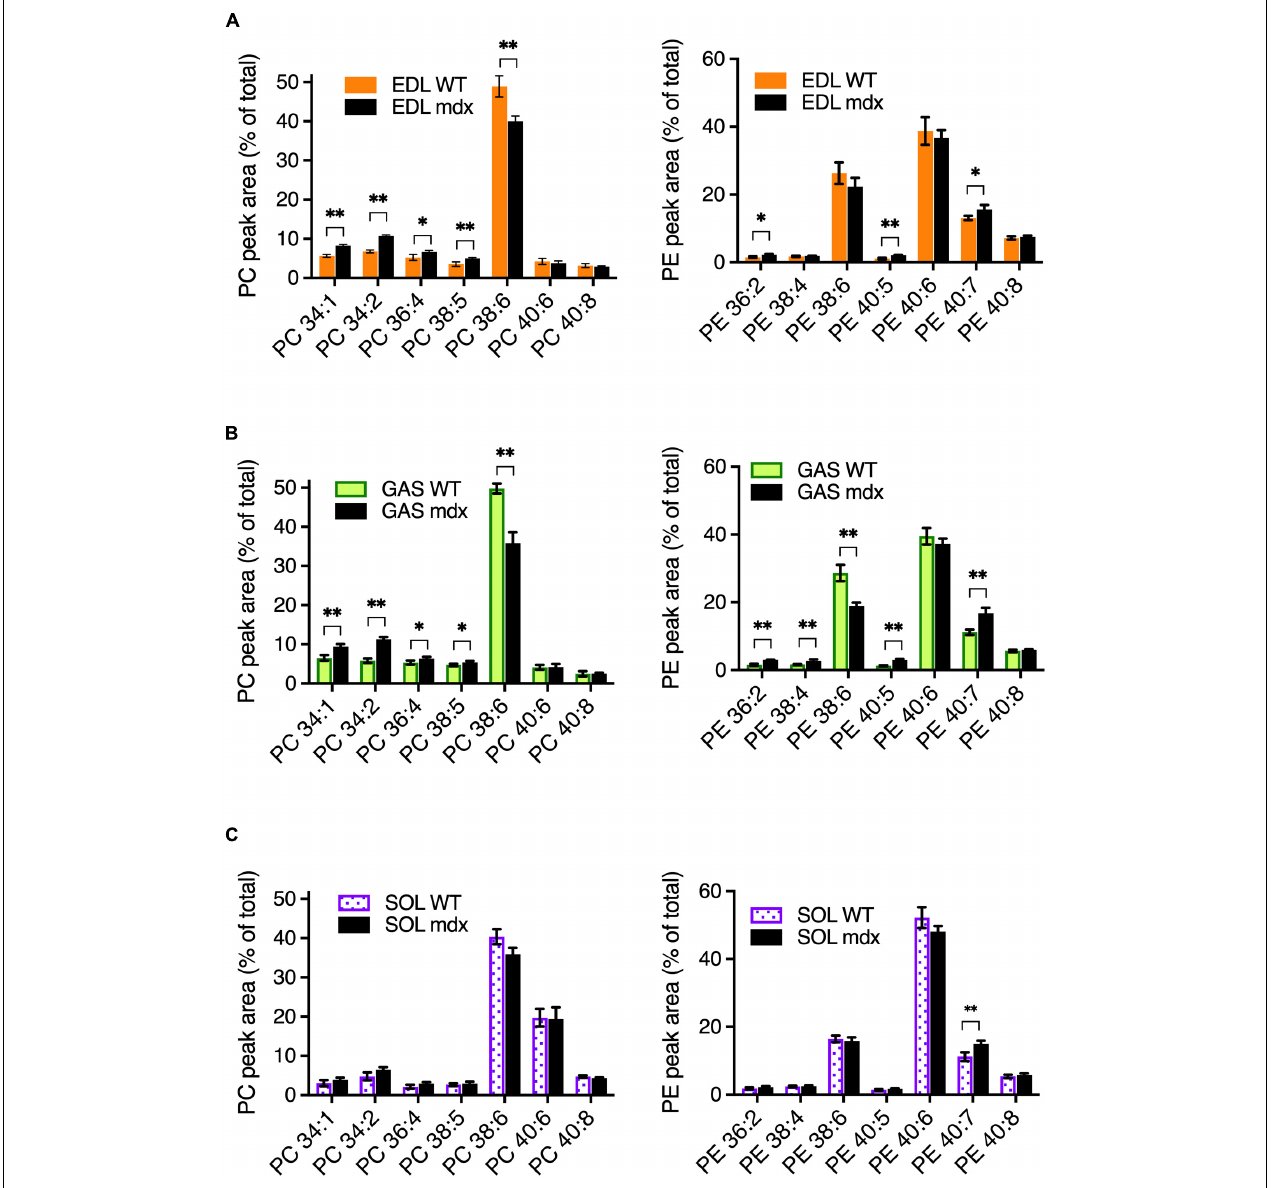
FIGURE 3 | Mdx -related PC and PE alterations in EDL, GAS, and SOL of adult (18-week-old) B10-WT and - mdx mice raised on CE-2 standard chow. EDL (A) and GAS (B) showed similar patterns of mdx -associated PC alterations. PC alterations were diminished in SOL (C) . The most prominent mdx -associated PC alterations in EDL and GAS were high PC 34:1, high PC 34:2, and reduced PC 38:6 levels. Mdx -associated alterations in PE are also shown. PC and PE were measured by LC-MS/MS. Peak values are expressed as the percentage of total PC or PE signals and means ± SD are plotted. Statistical significance of corresponding WT and mdx tissues is based on FDR-controlled multiple t -tests (FDR < 5%). ∗ p < 0.05, ∗∗ p < 0.01; n = 3–5